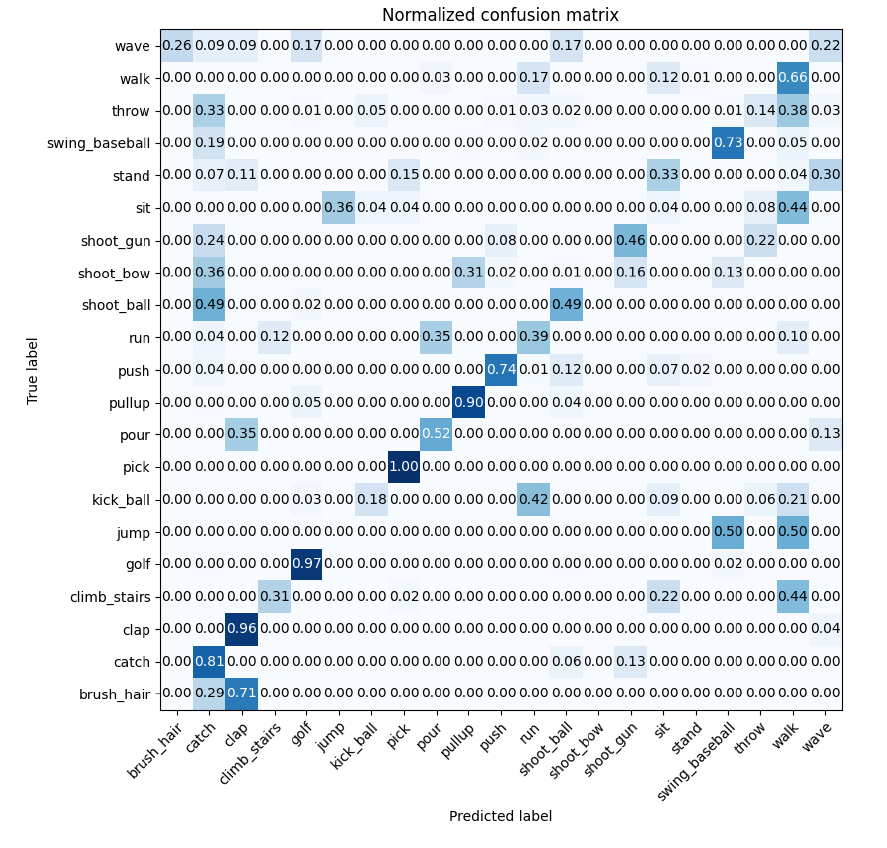
Figure 7. Confusion matrix of JHMDB-split1 obtained by the proposed pipeline, with darker color indicates higher